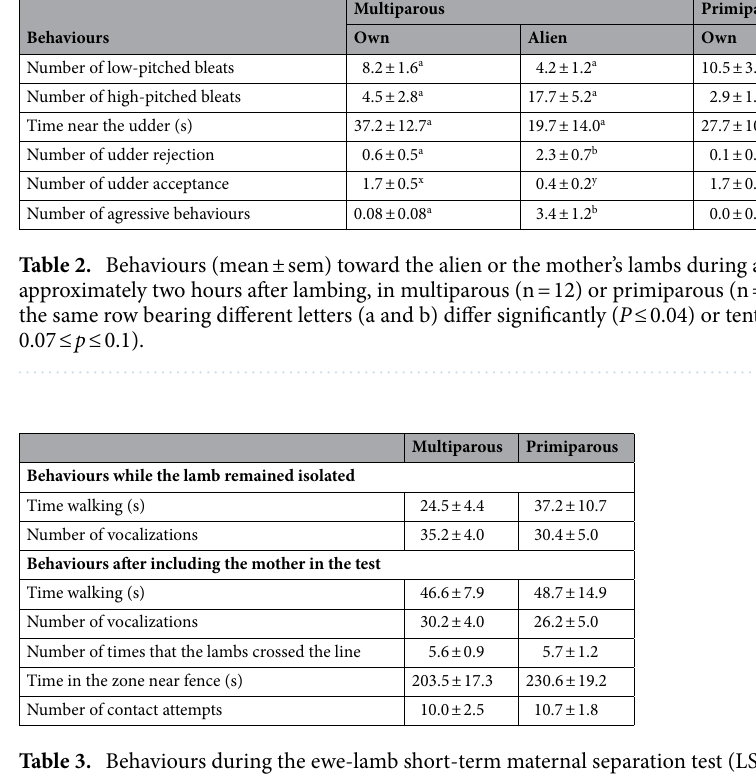
Table 3. Behaviours during the ewe-lamb short-term maternal separation test (LS mean ± sem) in lambs at 3 months of age reared by multiparous (n = 19) or primiparous (n = 12) ewes. There were no significant differences between